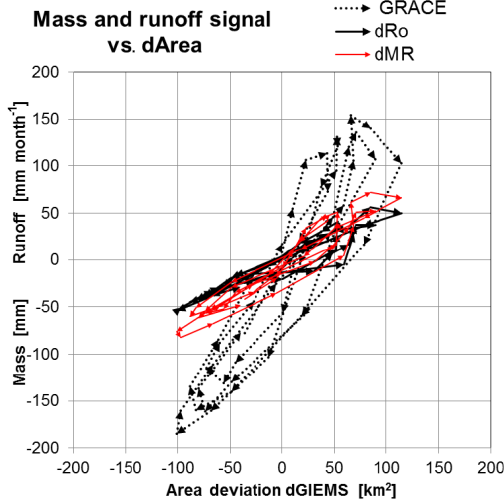
Figure 12. GRACE mass, calculated river network mass d M R and observed river runoff dR o versus flood area dGIEMS, all displayed as anomalies (please consider d M R = d R R τ R = 1 . 53d R R